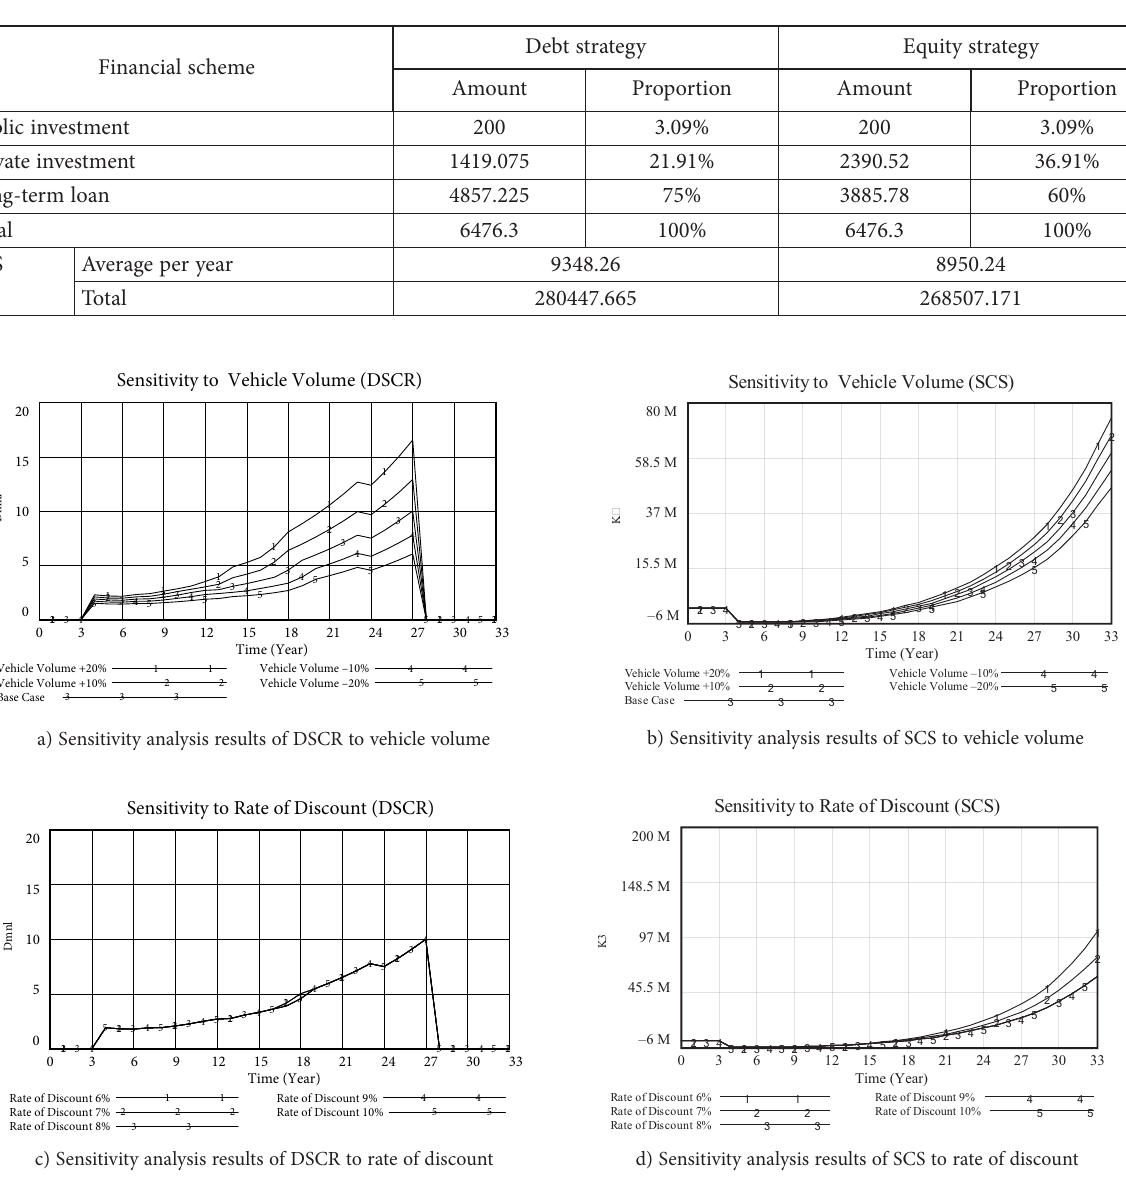
Figure 13. Sensitivity analysis